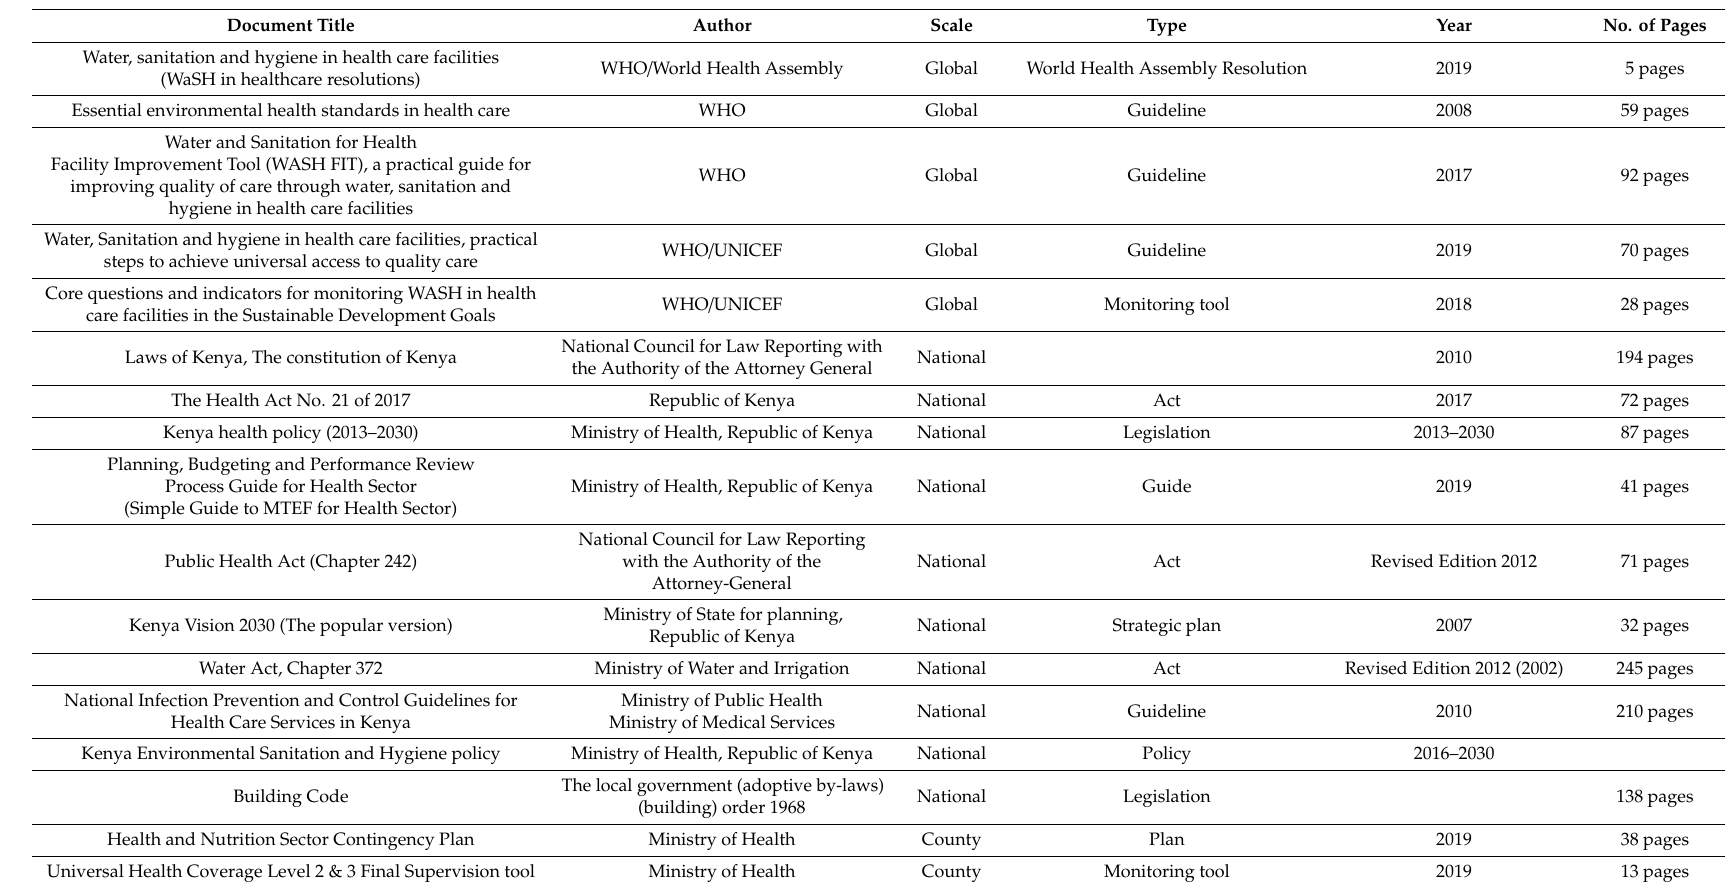
Table 1. List of documents included in the